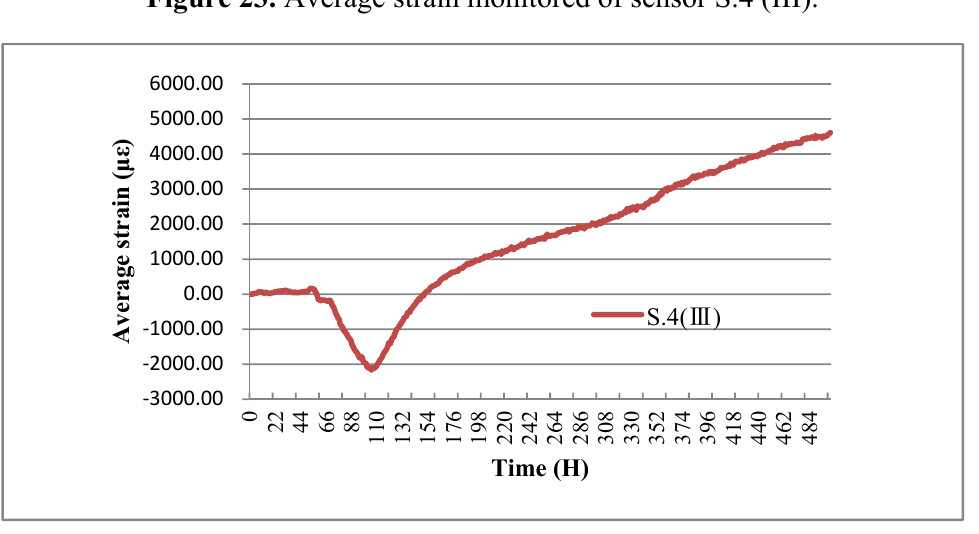
Figure 23. Average strain monitored of sensor S.4